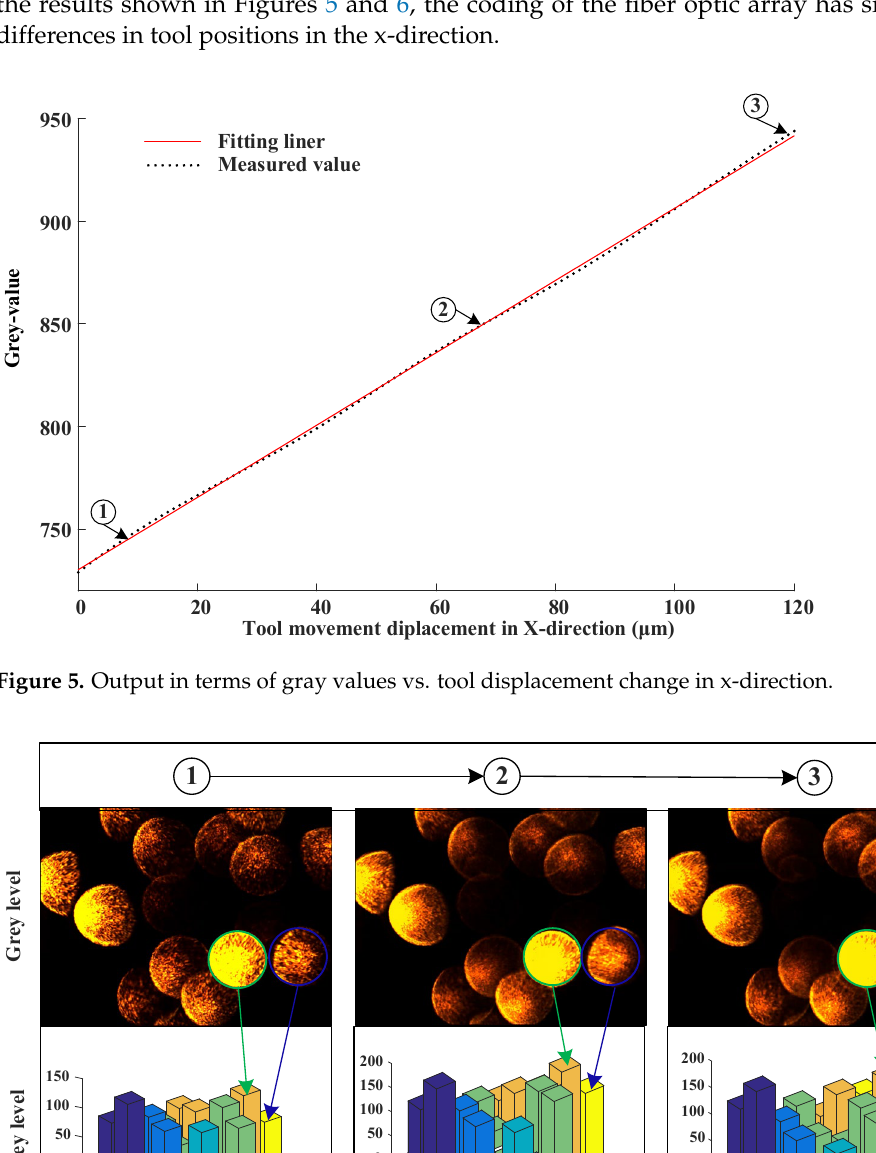
(8) The maximum linear error is 2.58% between the fitting line and measurement data in the range marked by the fitting line in Figure 7. Similar to the above evaluation method shown in ref. [37], the maximum measurement uncertainty was calculated as 1.24 µm for the range of 120 microns. It can be seen that the signal is strongest when the tool is facing the axis of the fiber bundle. When the tool is far away from the center of the optical field, the optical intensity received by the optical array decreases because of the influence of the numerical aperture of the fiber and the arc of the tool surface. However, although the curves shown on the left and right sides are basically symmetrical in Figure 7, it can be found that there is an obvious difference between measurement points 2 and 4 by com- paring the pictures and their gray coding of the two points. In other words, this code not only reflects the tool displacement information but also reflects the tool motion direction information.